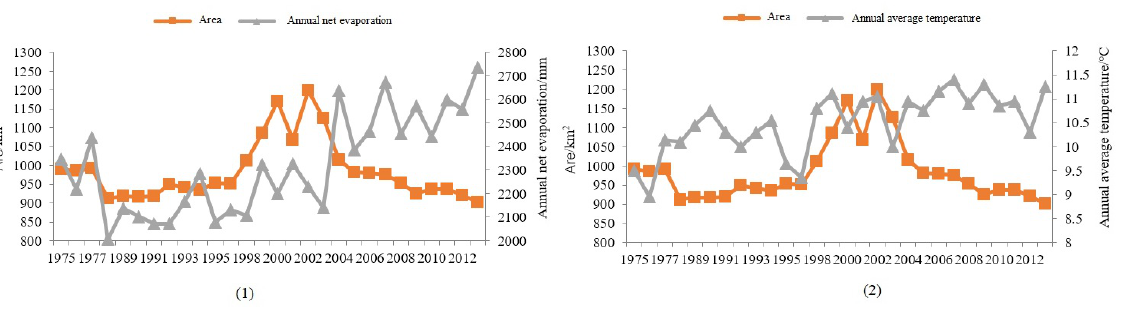
Figure 4. Comparison of area of Bositeng Lake and (2) annual average temperature (1) annual net evaporation